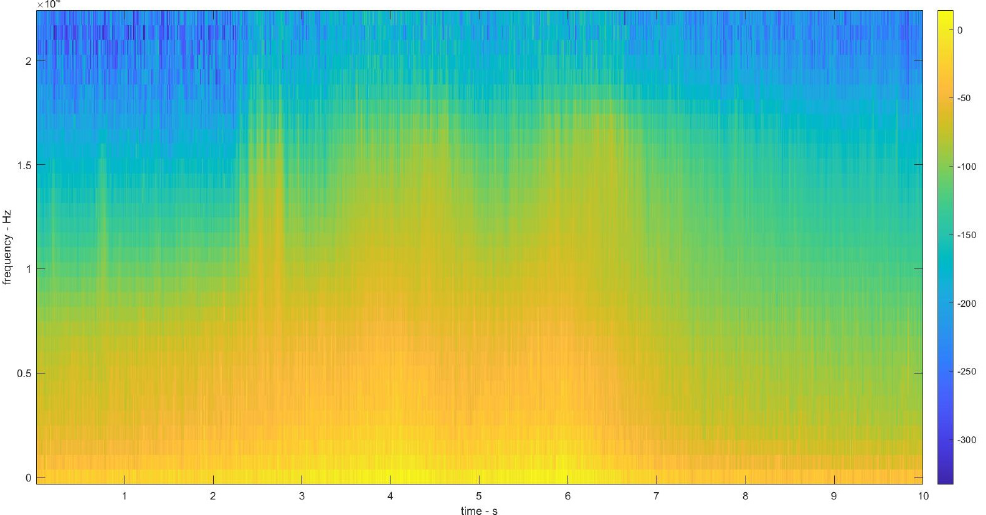
Figure 8. Empirical mode decomposition-based Mel spectrogram from a 10 sec audio file of a car